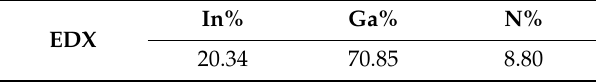
Table 1. EDX results of In 0.1 Ga 0.9 N film.